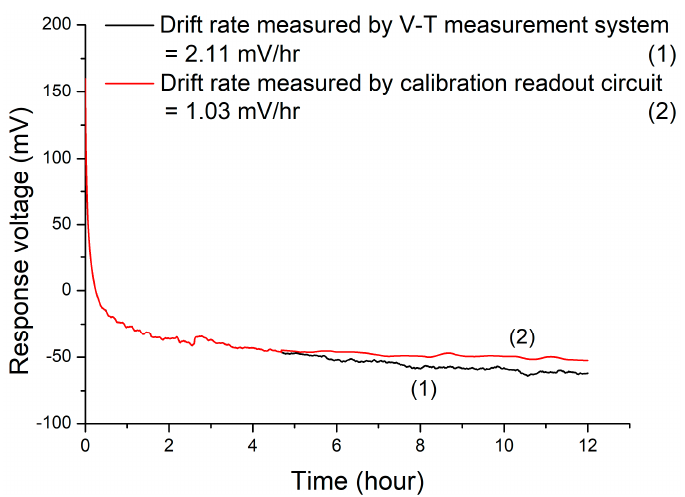
Figure 11. Drift rates of the AgNWs/CZO sensor after using the calibration readout circuit.